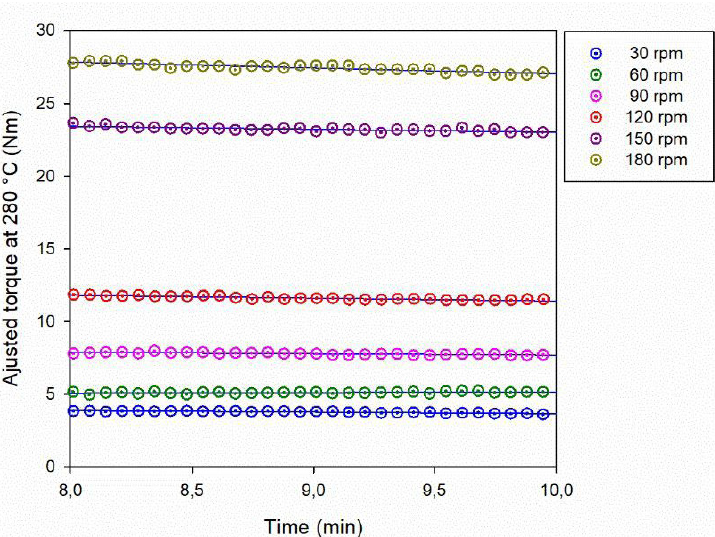
Figure 4. Adjusted Torque as a function of time in the 8-10 min processing time interval, for experiments performed at constant wall temperature and varying rotor